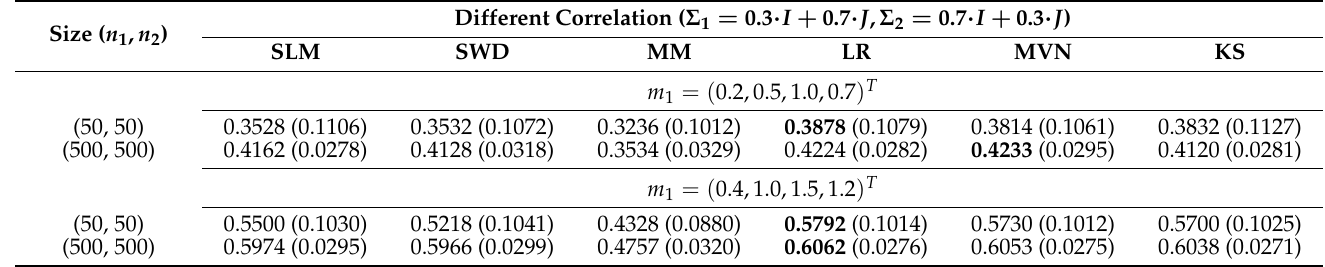
Table 12. Normal distributions: Different means and unequal positive correlations. Validation. Size ( n 1 , n 2